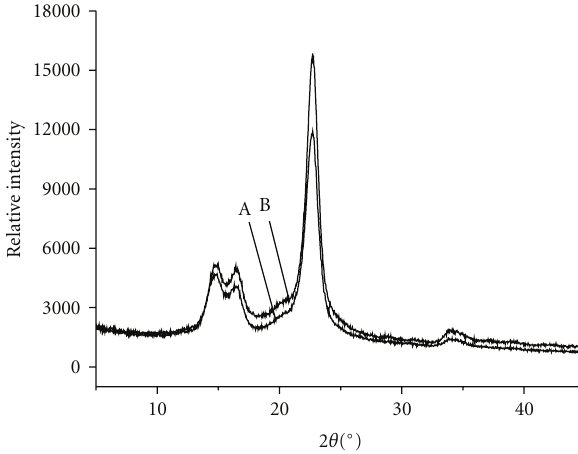
Figure 7: X-ray di ff raction profiles of the untreated (A) and treated cotton